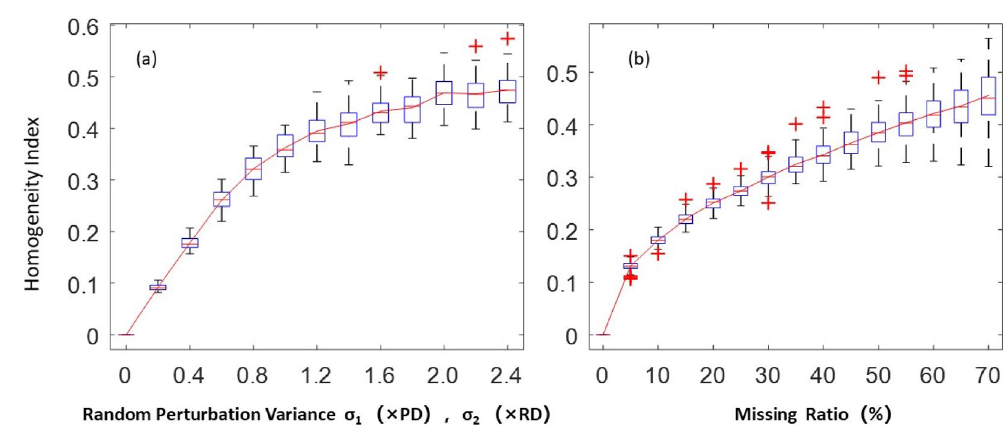
Figure 8. Trend of the changes in the heterogeneity index with the increasing variance under random perturbation ( a ) and with the omission ratio ( b